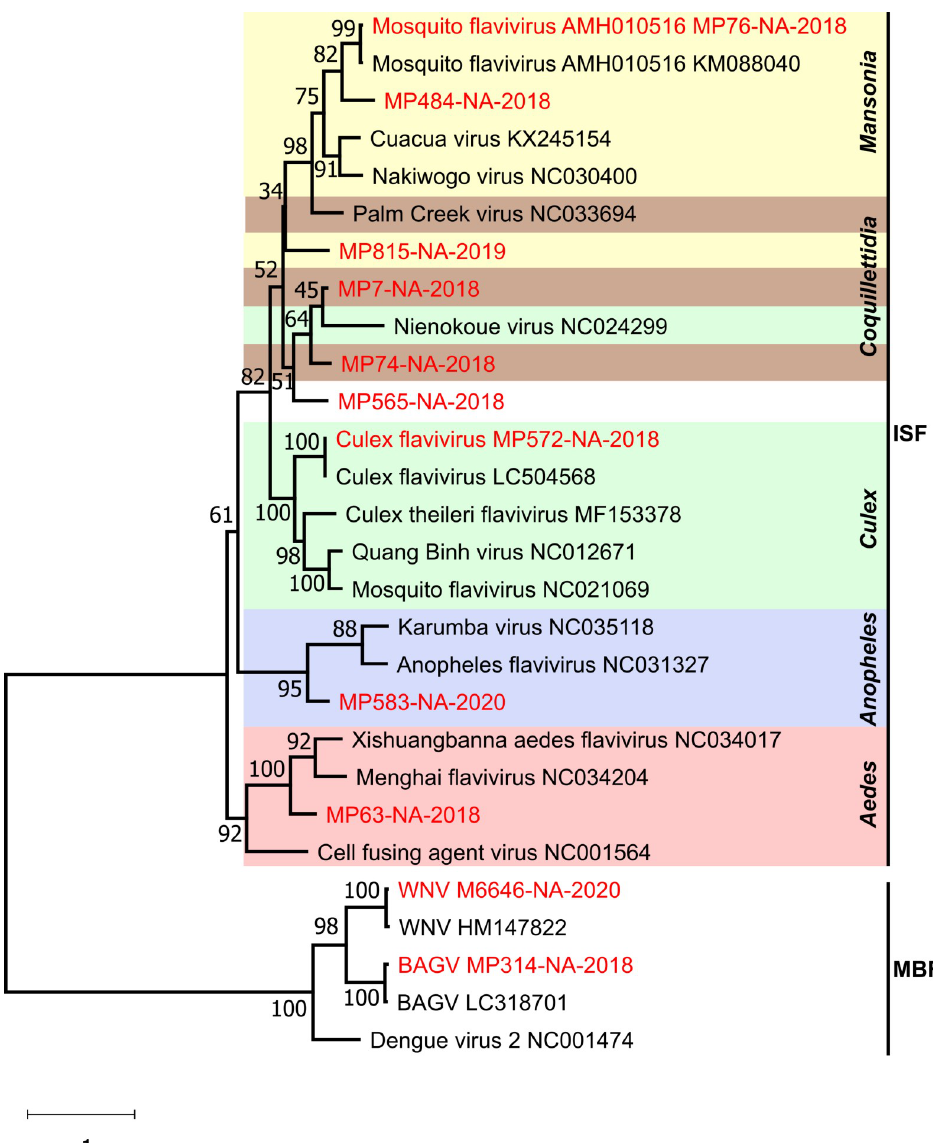
Fig 3. Phylogenetic relationship of flaviviruses detected in the Zambezi region. The phylogenetic tree is based on RdRP gene sequences of 153 nucleotides. Branch support is shown at each branch. Virus sequences detected in this work are shown in red. Gen Bank accession numbers are marked in